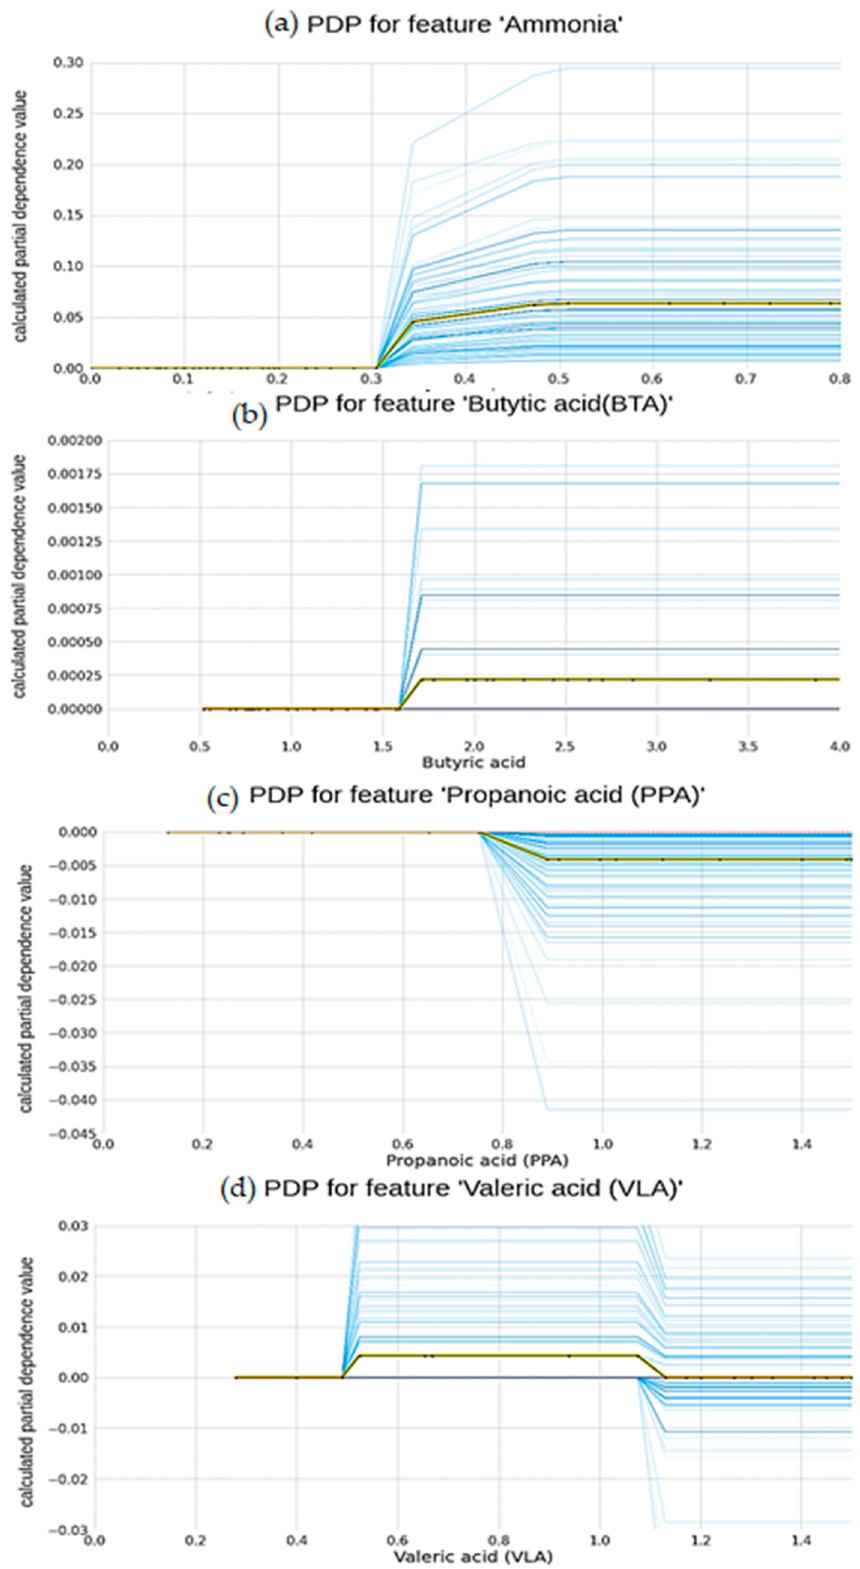
Figure 8. Partial dependence isolation plots for four main odor species (NH 3 , PPA, BTA, and VLA). The blue line means all analyzed cases in the data, and the green line in the center means the average of all blue lines.